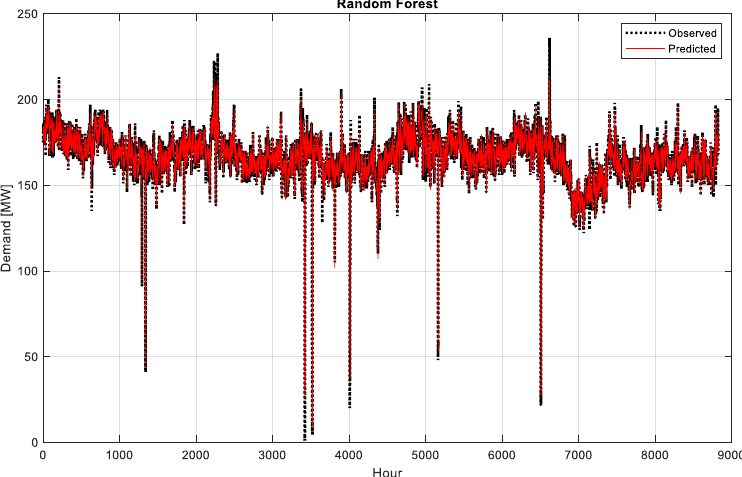
Figure 11. The ESC demand Forecasting using the Random Forest model optimized using BO.